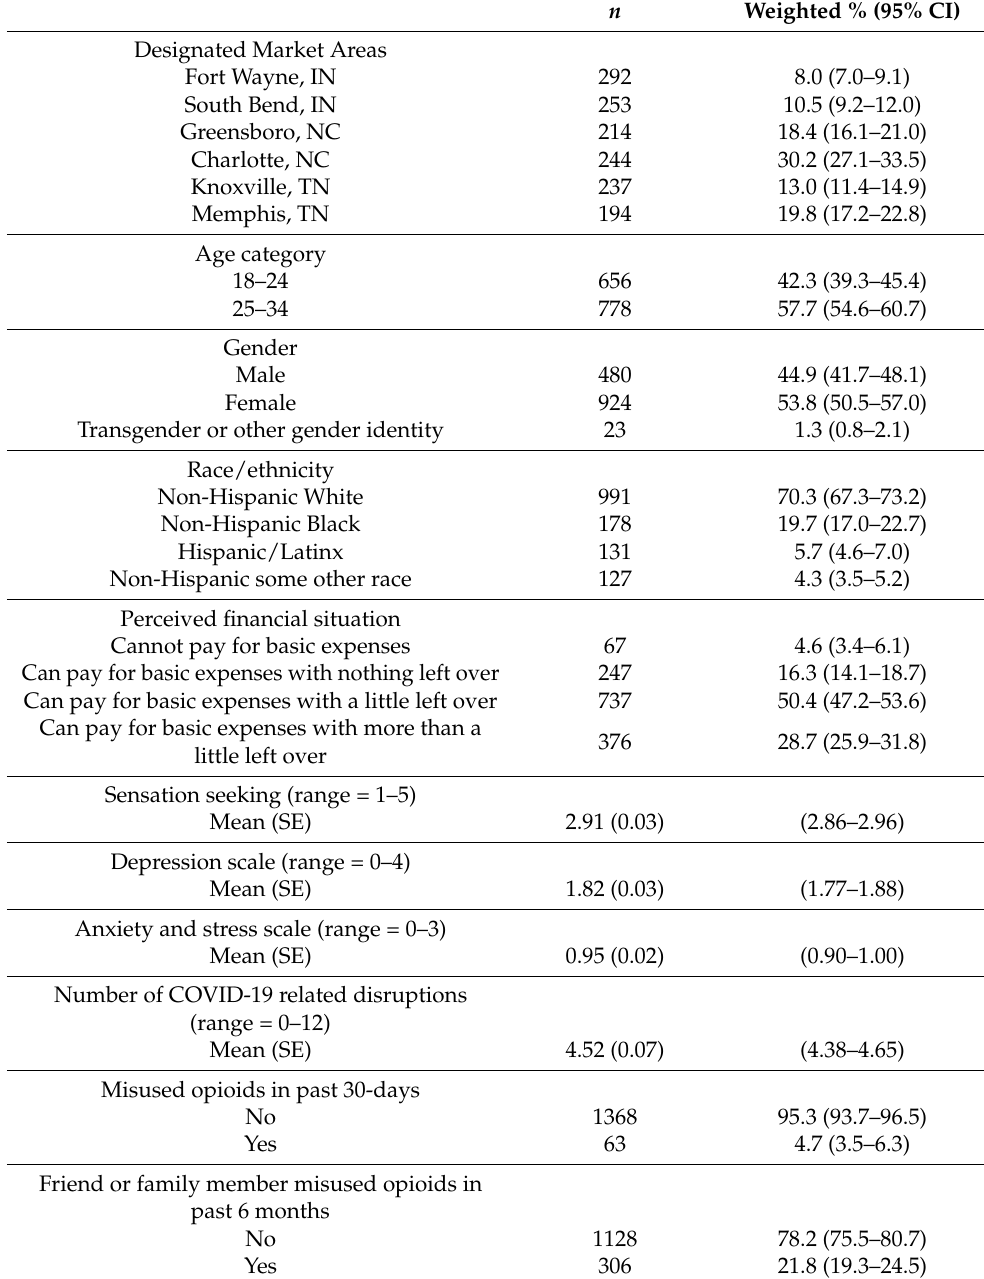
Table 1. Sample Characteristics ( N =